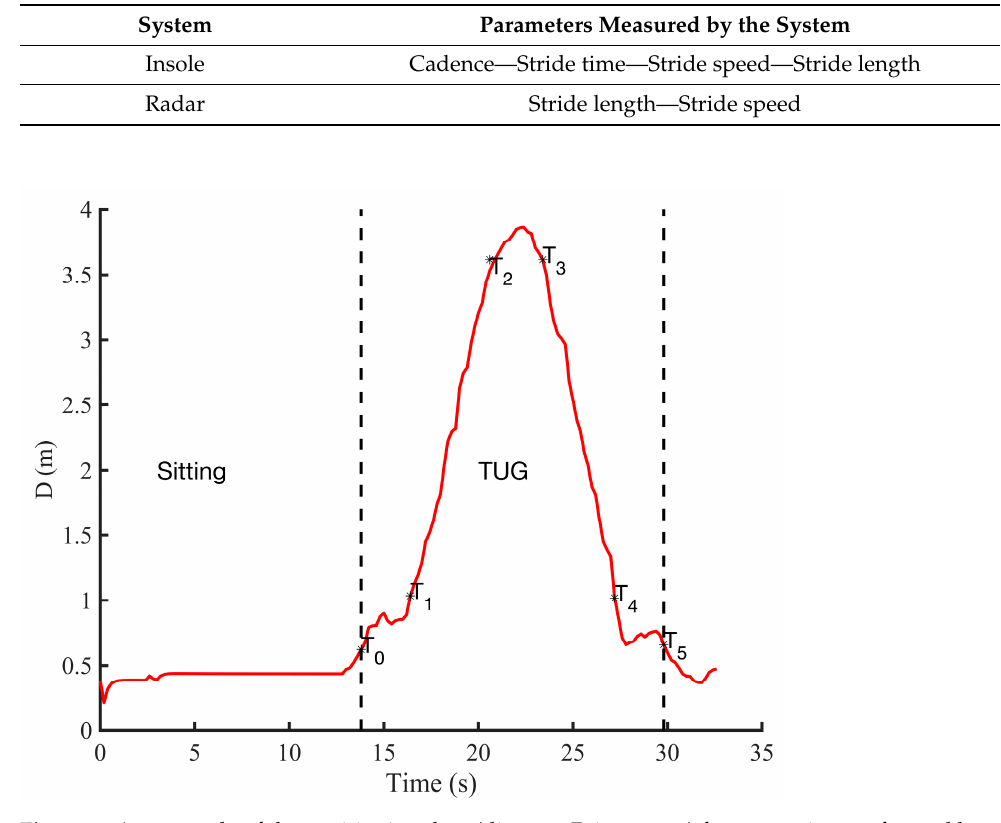
Figure 5. An example of the positioning data (distance D in meters) from a testing performed by a healthy young adult showing the different points detected for TUG activities segmentation. TUG: Timed Up and Go. Table 1. Gait parameters computed by the instrumented insole and the radar during the TUG test.